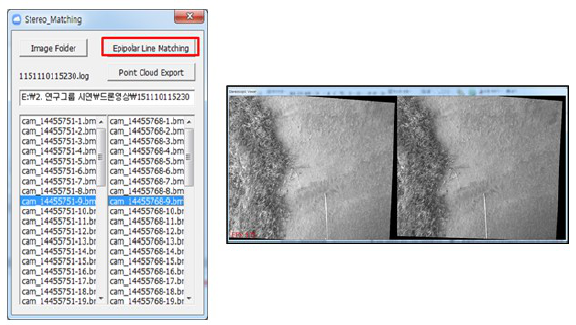
Figure 1. Epipolar Matrix Calculation